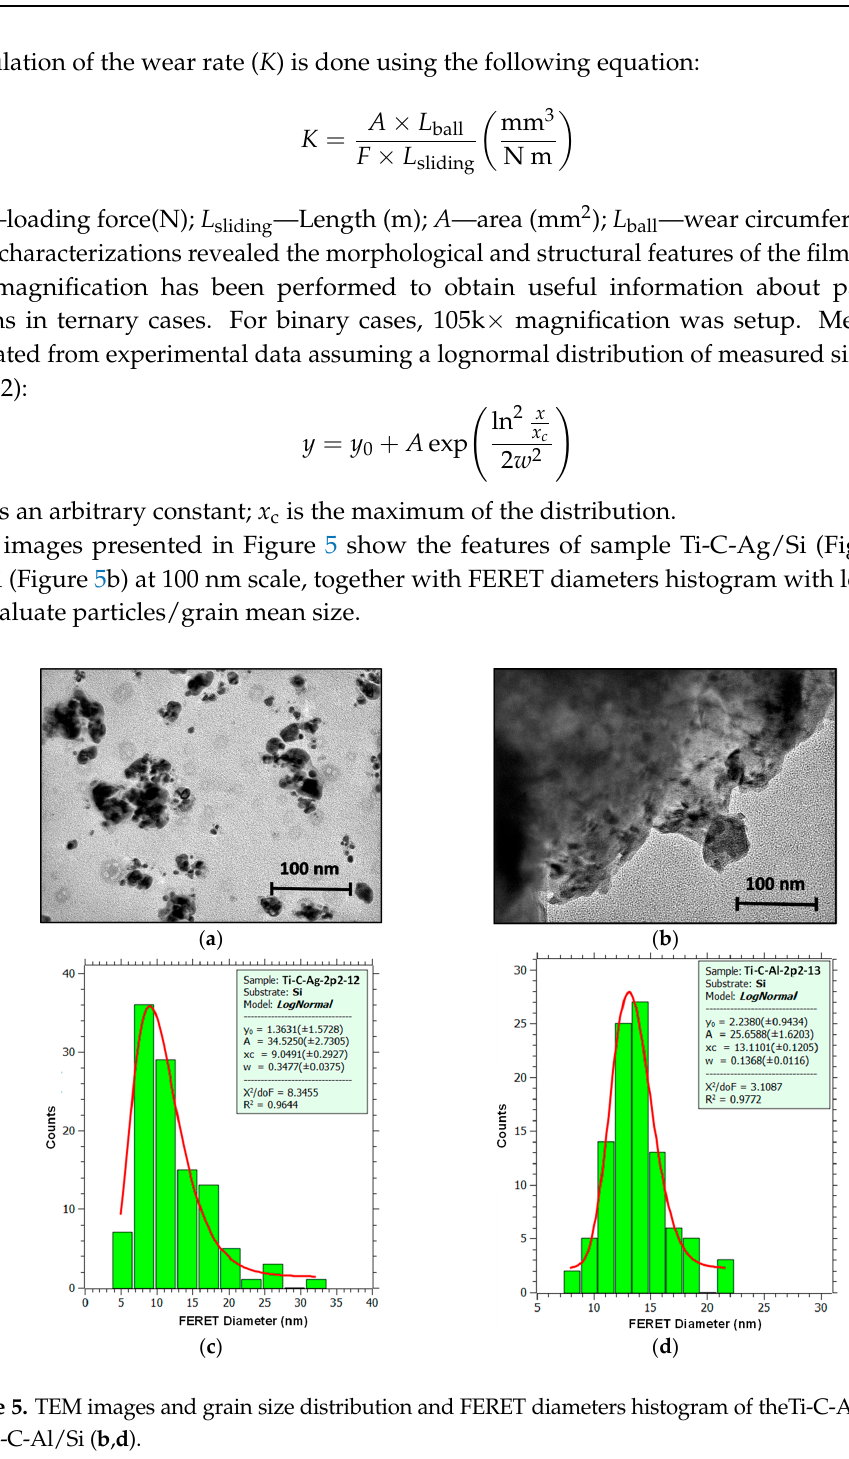
Table 2. Area and wear rates of thin films.